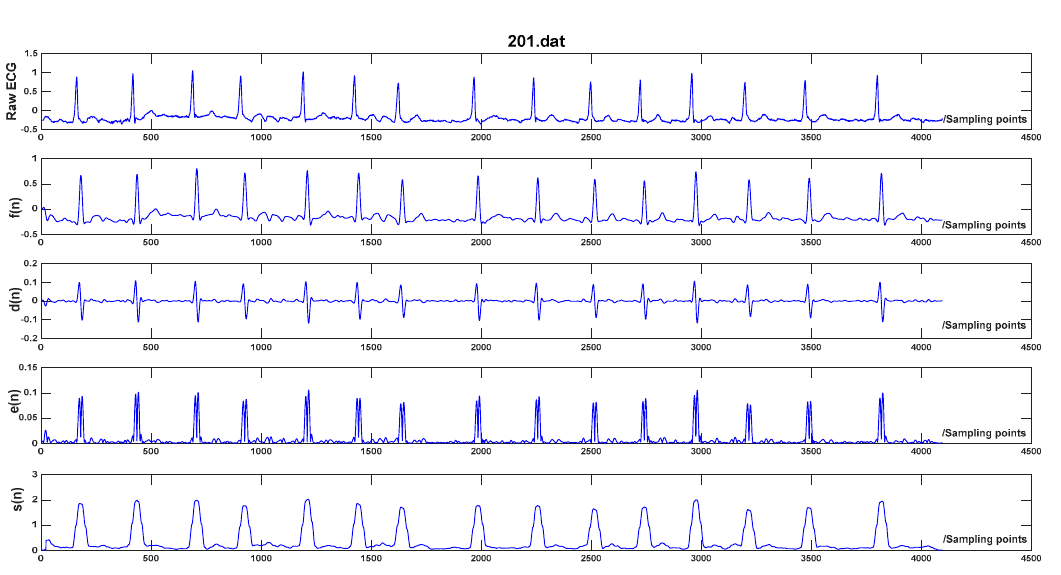
Figure 2. Preprocessing of record 201 in MIT-BIH Arrhythmia Database, f(n) represents the filtered ECG, d(n) stands for the differential ECG, e(n) is the signal after exponential transformation, and s(n) is the accumulation result.